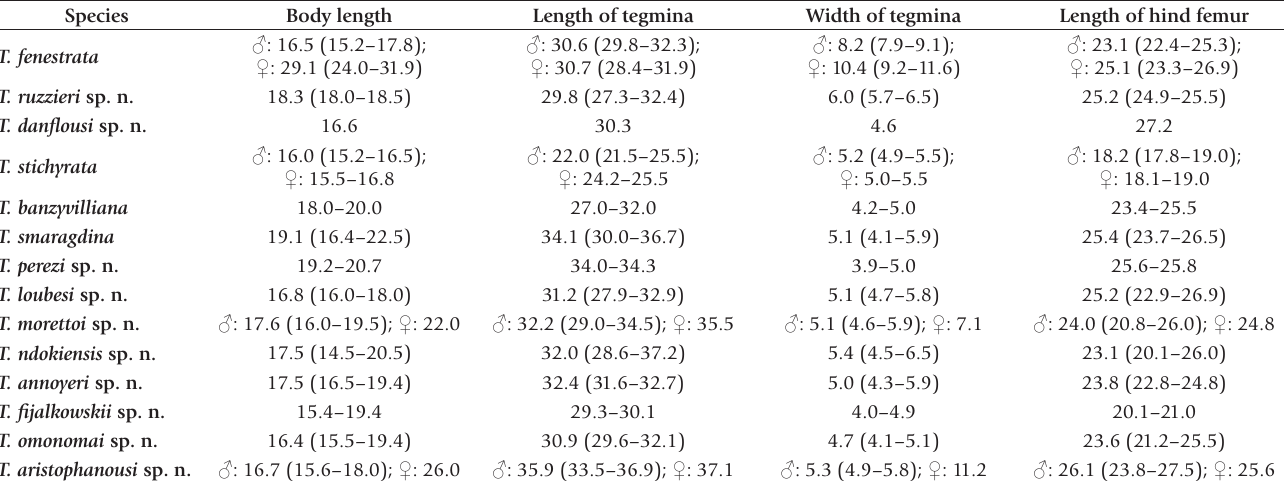
Table 2. Biometrics of males of the genus Tetraconcha . Measurements in mm. Species Body length Length of tegmina Width of tegmina Length of hind